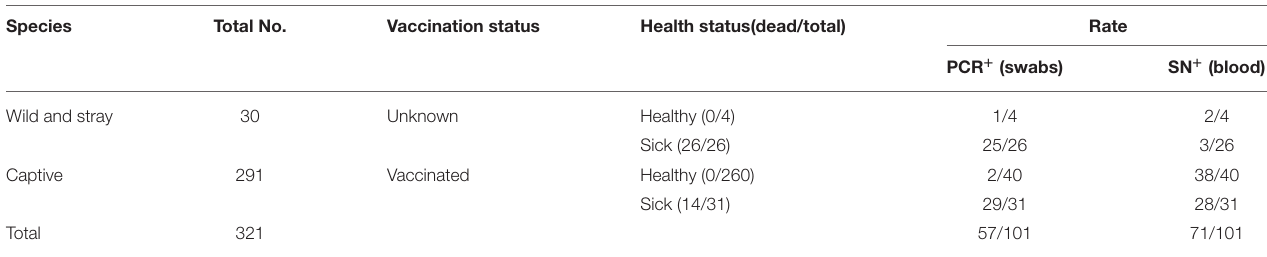
TABLE 1 | Detection of civet CDV in sick and healthy animals using PCR and SN test. Species Total